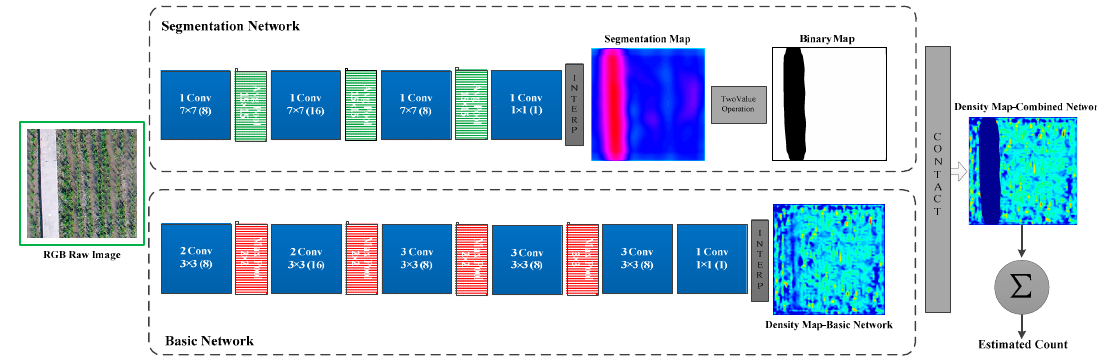
Figure 3. The proposed Combined Network method for counting rice seedlings.